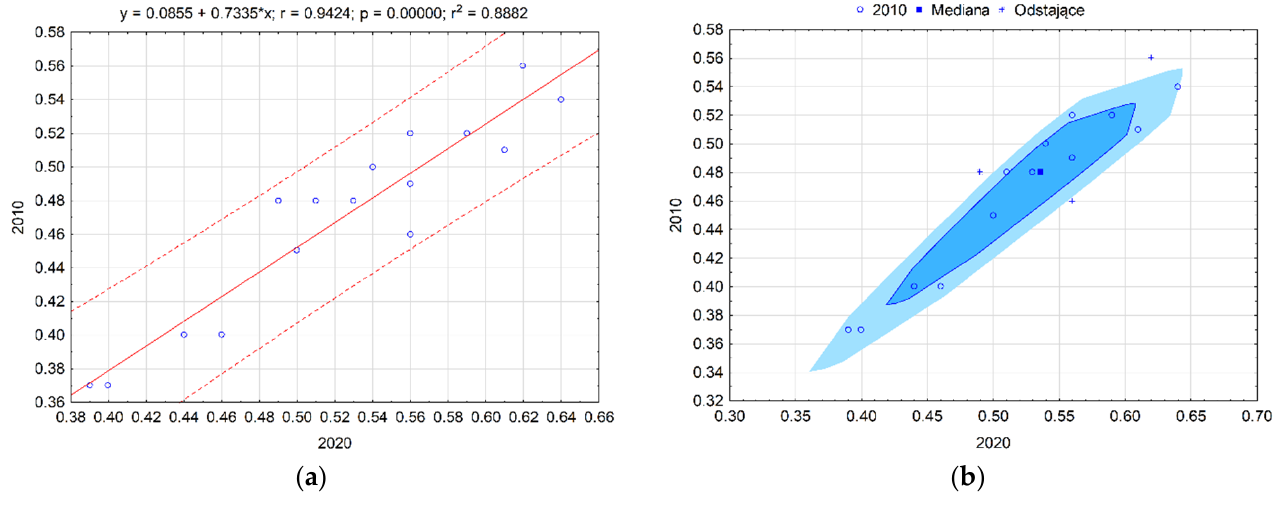
Figure 3. Scatter plot with the fit line ( a ) and bag chart ( b ) of the synthetic measure of the quality of life of voivodships in Poland. Source: own study based on the BDL CSO data.